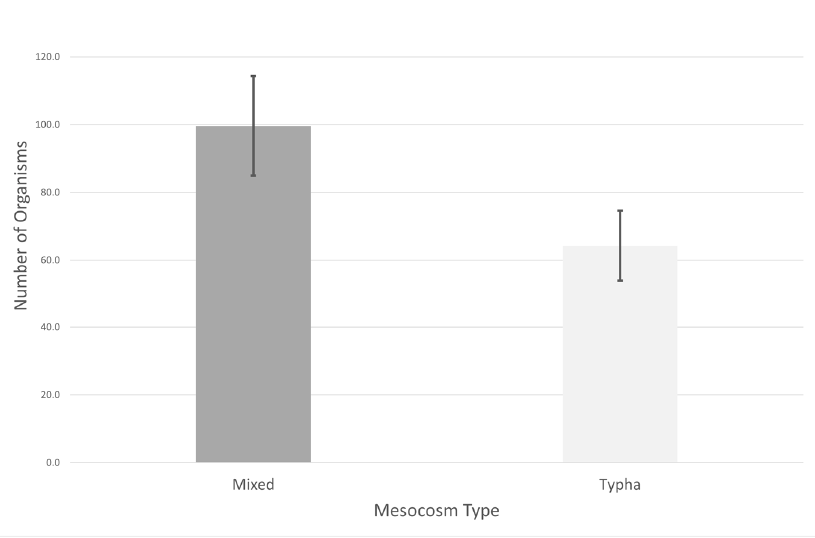
Figure 4. HD samples: the number of taxa ( ± standard error) found approaches significance by mesocosm type ( p < 0.10; t = − 1.97; df = 38).